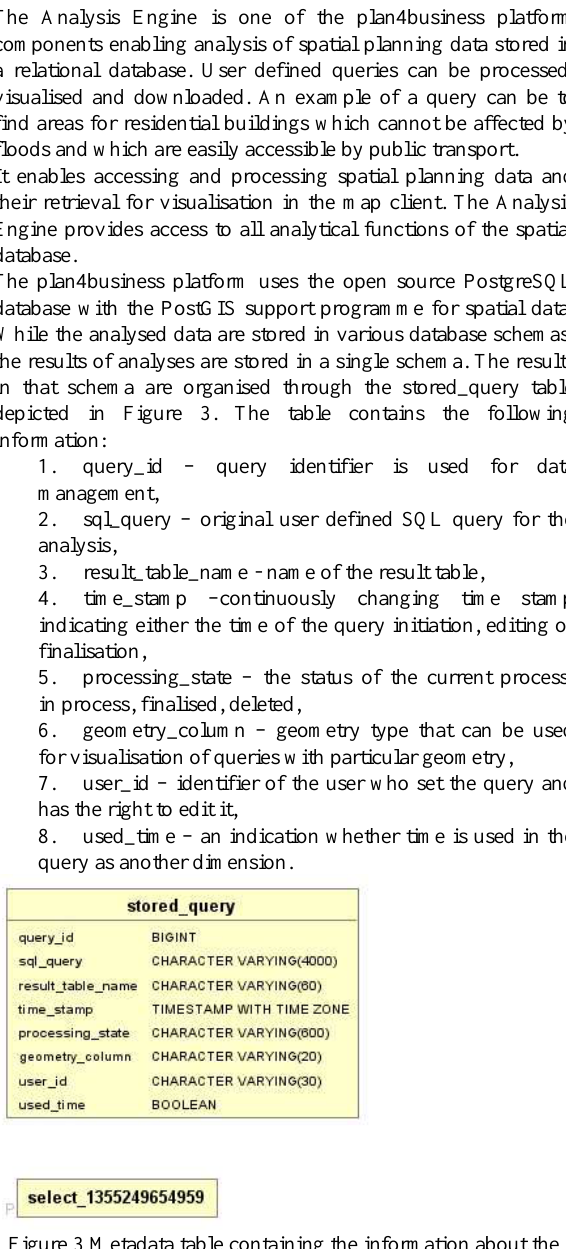
Figure 3 Metadata table containing the information about the analysis result (Ježek et al.